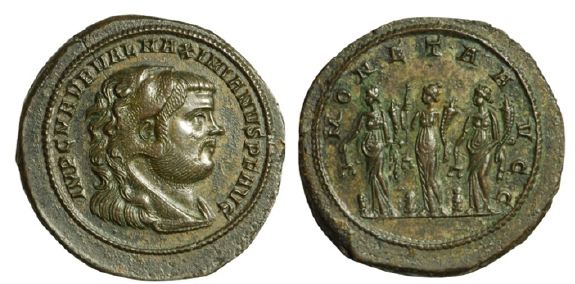
Figure 1. The Maximianus Herculeus’